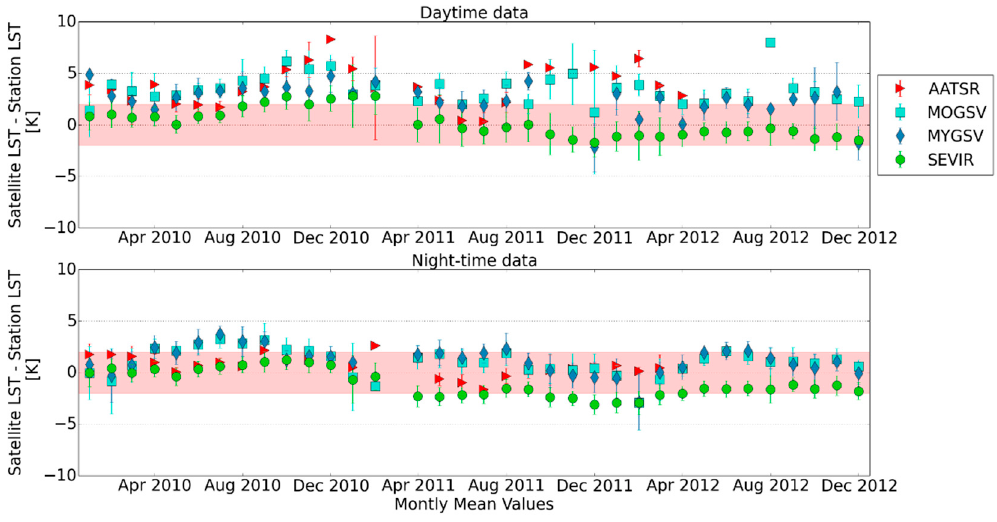
Figure 10. Monthly median accuracies (satellite LST–station LST) over GBB_W station for the years 2010–2012. The upper plot shows daytime and the lower night-time data. The ranges shaded in red indicate the ± 2.0 K accuracy range.